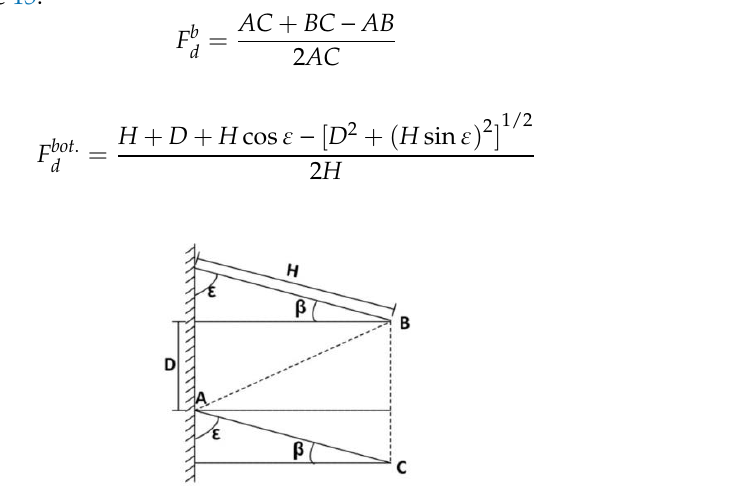
Figure 15. Calculation of sky view factor.